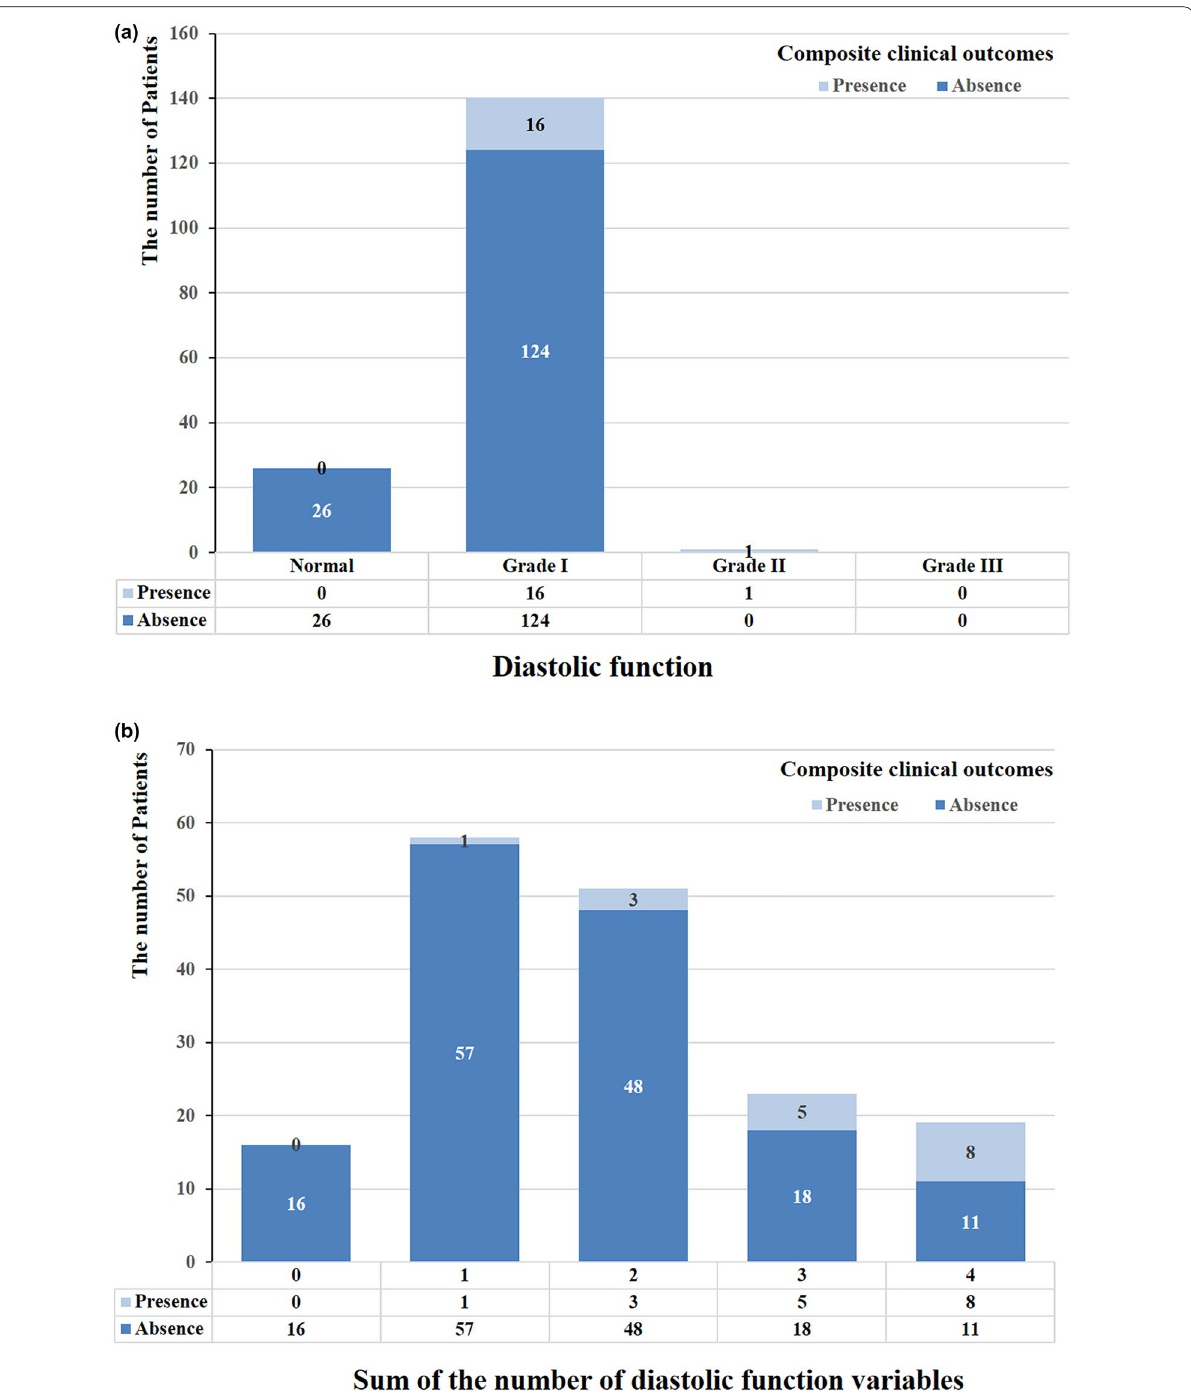
Fig. 3 Diastolic dysfunction (DD) and composite clinical outcomes. A. Most of the patients were classed as having Grade I DD according to the 2009 guidelines. B. The greater the number of DD variables, the higher the probability of composite clinical outcomes according to the revised 2016